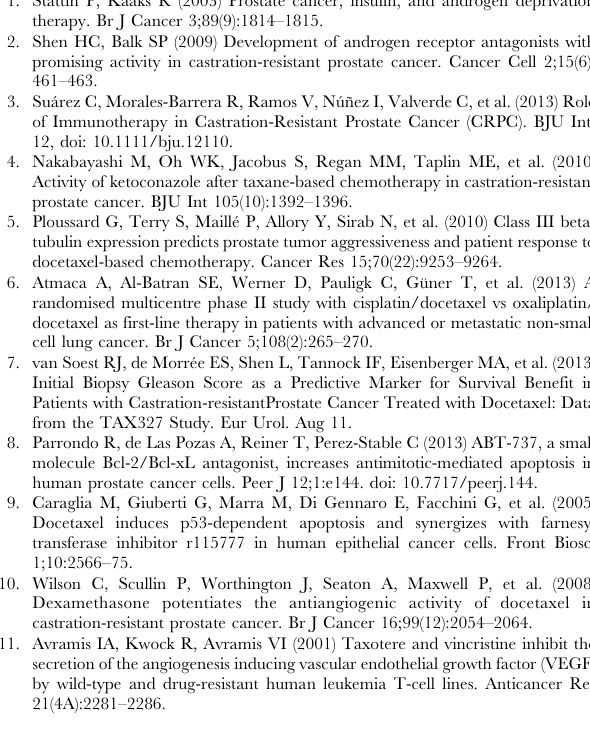
Figure S1 Effect of DTX alone, synergistic effect of DTX in combination with 100 nM OCT on PC3 cells prolifer- ation following 48 h (A) and 72 h (B) of treatment. Results are the percentage of control value obtained with untreated cells (mean 6 SEM of three experiments done in triplicate). (**) Proliferation was significantly decreased ( p , 0.001); error bars =- SEM. Figure S2 Synergistic effect of DTX in combination with OCT on DU145 cells proliferation following 48 h of treatment. Results are the percentage of control value obtained